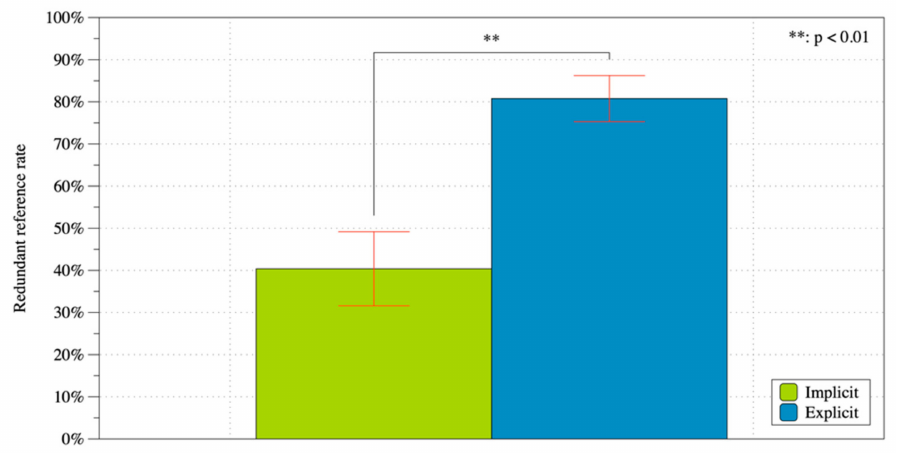
Figure 16. Comparison of rates of redundant references with standard error between explicit request and implicit